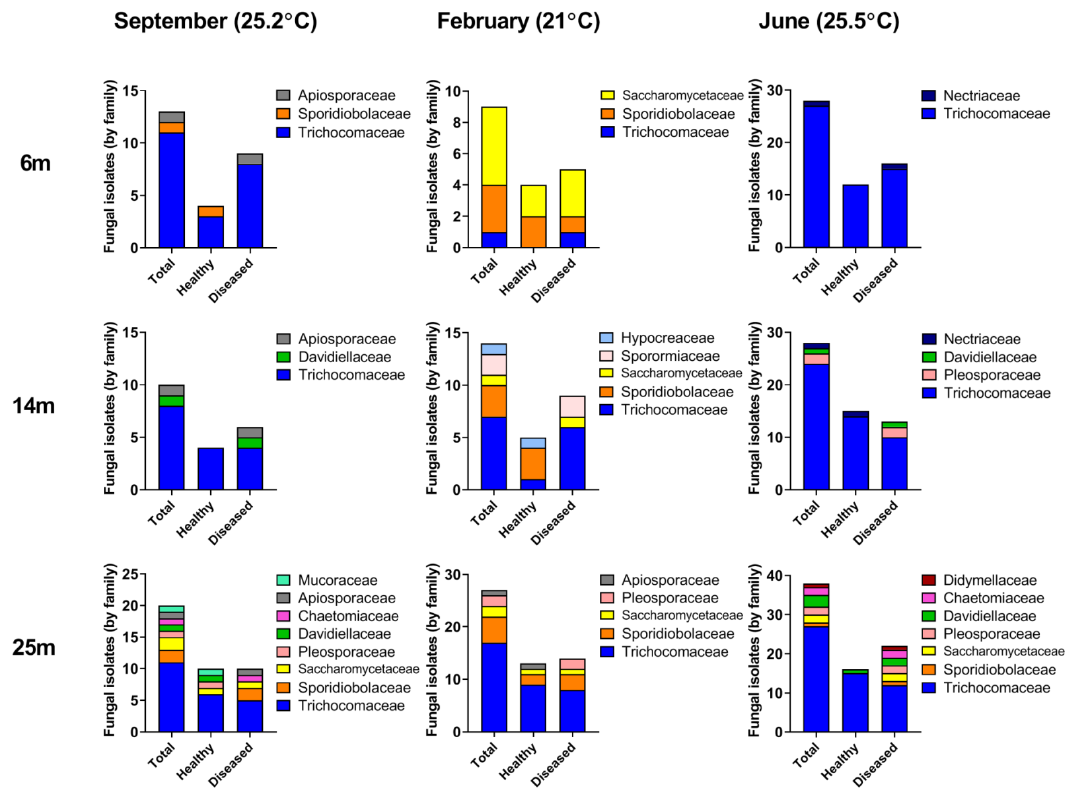
Figure 3. Prevalence of Acropora loripes -associated fungal families during the various seasons and along a depth gradient in the Red Sea. The total number of taxa, by family, as well as distribution between apparently-healthy and lesioned coral samples, is shown.